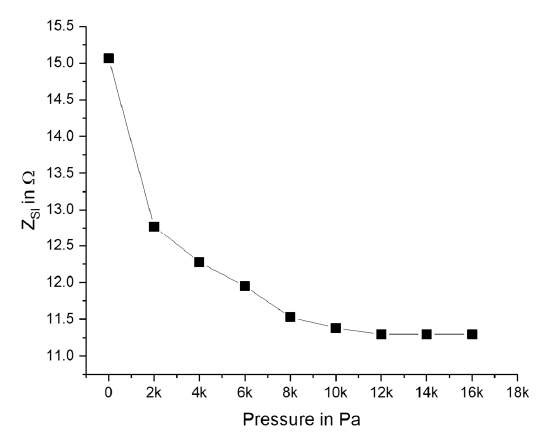
Figure 9. Derived magnitude of the impedance Z SI of the sensor as a function of the applied pressure at 200 MHz.